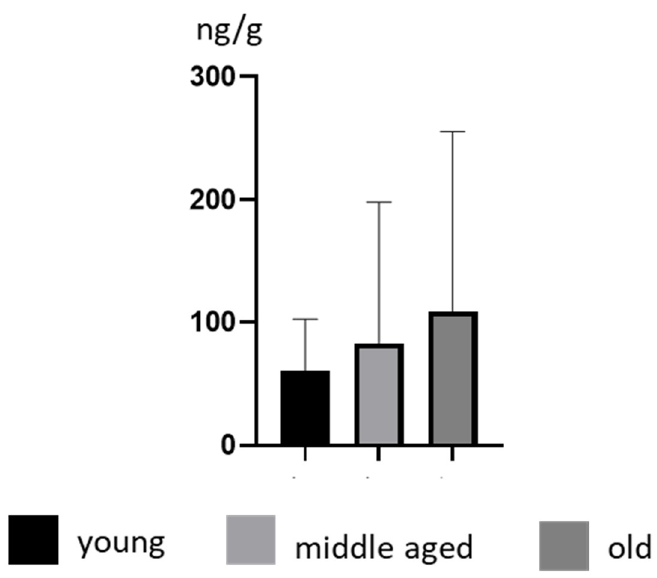
Figure 2. Mean concentration levels (± SD) of BPA in young, middle-aged and old dogs. Differences in BPA concentration levels were also noted depending on the weight of the animals. The lowest mean BPA concentration levels, amounting to 26.62 ± 20.35 ng/g, were observed in dogs with physiological weight. This value was statistically significantly lower than the mean BPA concentration level noted in thinner dogs (91.08 ± 28.55 ng/g) and dogs with obesity (124.6 ± 137 ng/g) (Figure 3). The highest BPA concentration levels in skinnier dogs amounted to 126 ± 1.65 ng/g (noted in a Poodle), in dogs with physiological weight, 40.1 ± 2.19 ng/g (noted in a mongrel), and in dogs with obesity, 436 ± 7.16 (noted in a Golden Retriever) (Table